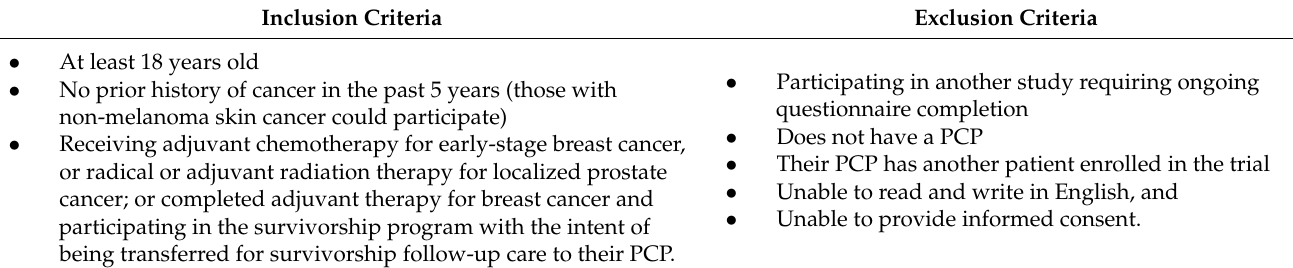
Table 1. Patient inclusion and exclusion criteria.